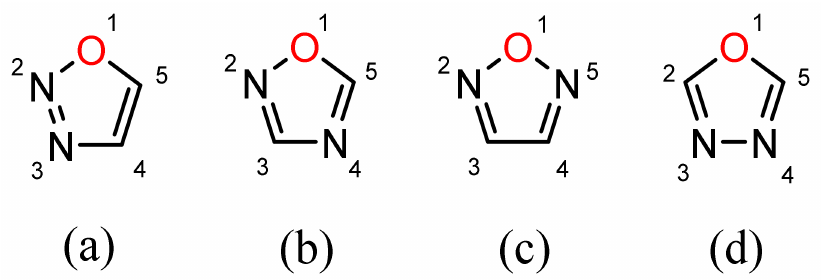
Figure 1. Four isomeric structures of oxadiazole: ( a ) 1,2,3-oxadiazole; ( b ) 1,2,4-oxadiazole; ( c ) 1,2,5- oxadiazole; and ( d )